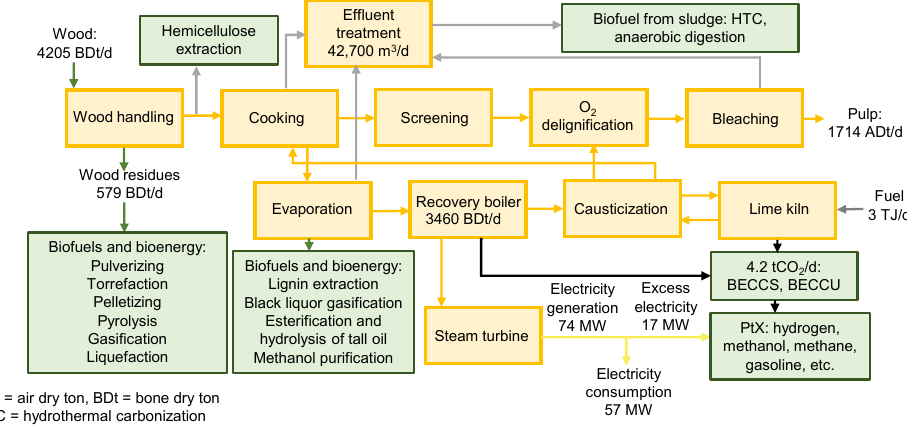
Figure 5. A northern stand-alone mill producing 600,000 ADt/a of softwood pulp and its future opportunities.